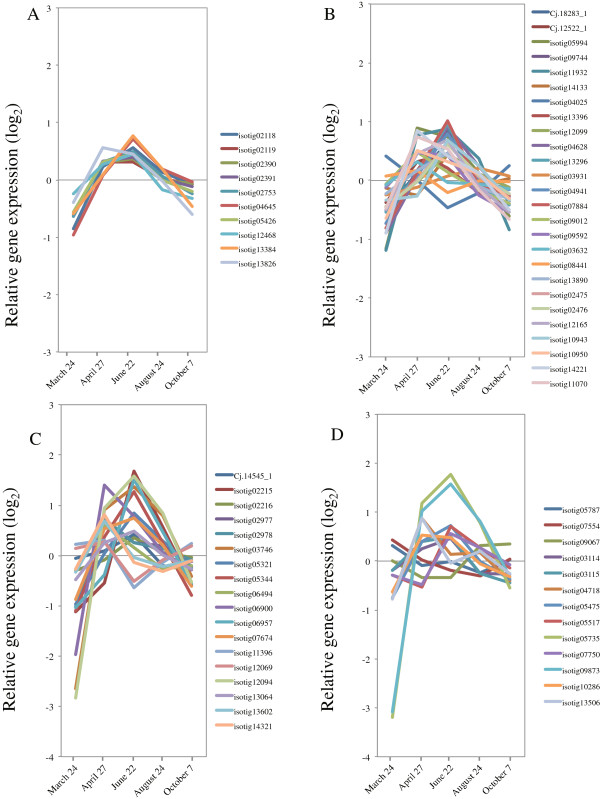
Expression of cytoskeleton related genes in cambial region during xylem formation. A) α/β-Tubulin. B) Actin, actin-related and actin interacting proteins. C) Kinesin gene family. D) Microtubule-associated protein gene family. The individual targets are summarized in Additional file 3. All expression data are presented on a log2 scale.